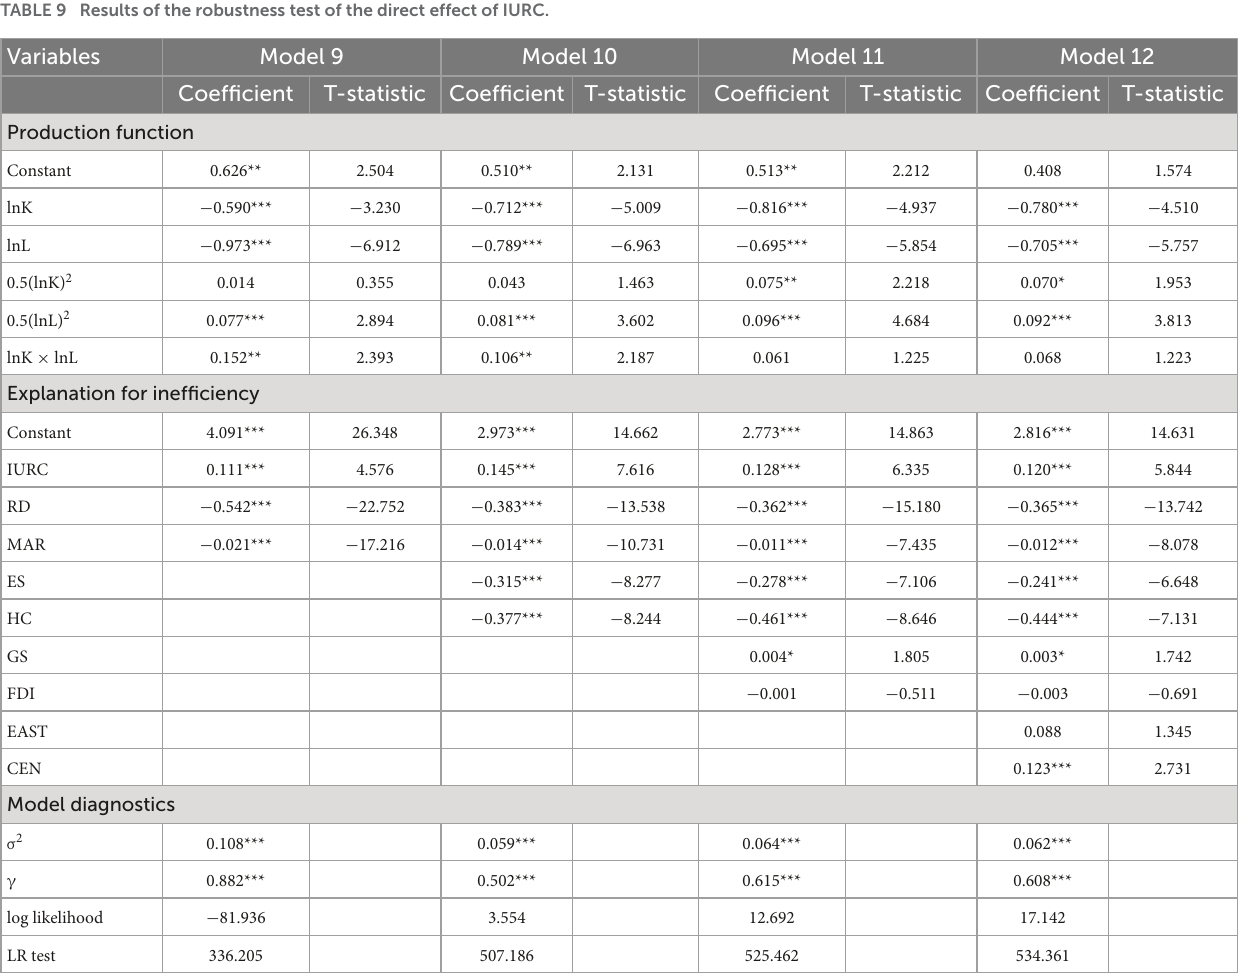
TABLE 9 Results of the robustness test of the direct effect of